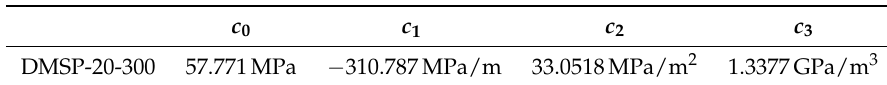
Table 1. Parameters c 0,1,2,3 for a DMSP-20-300 as a result of the optimization problem presented in [25]. c